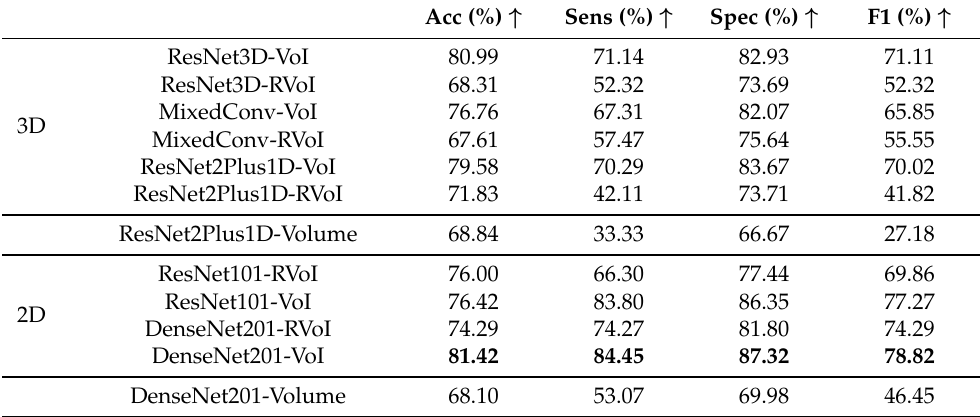
Table 6. Ablation results on the HUMC19-CT OS test set. Best results are highlighted with bold